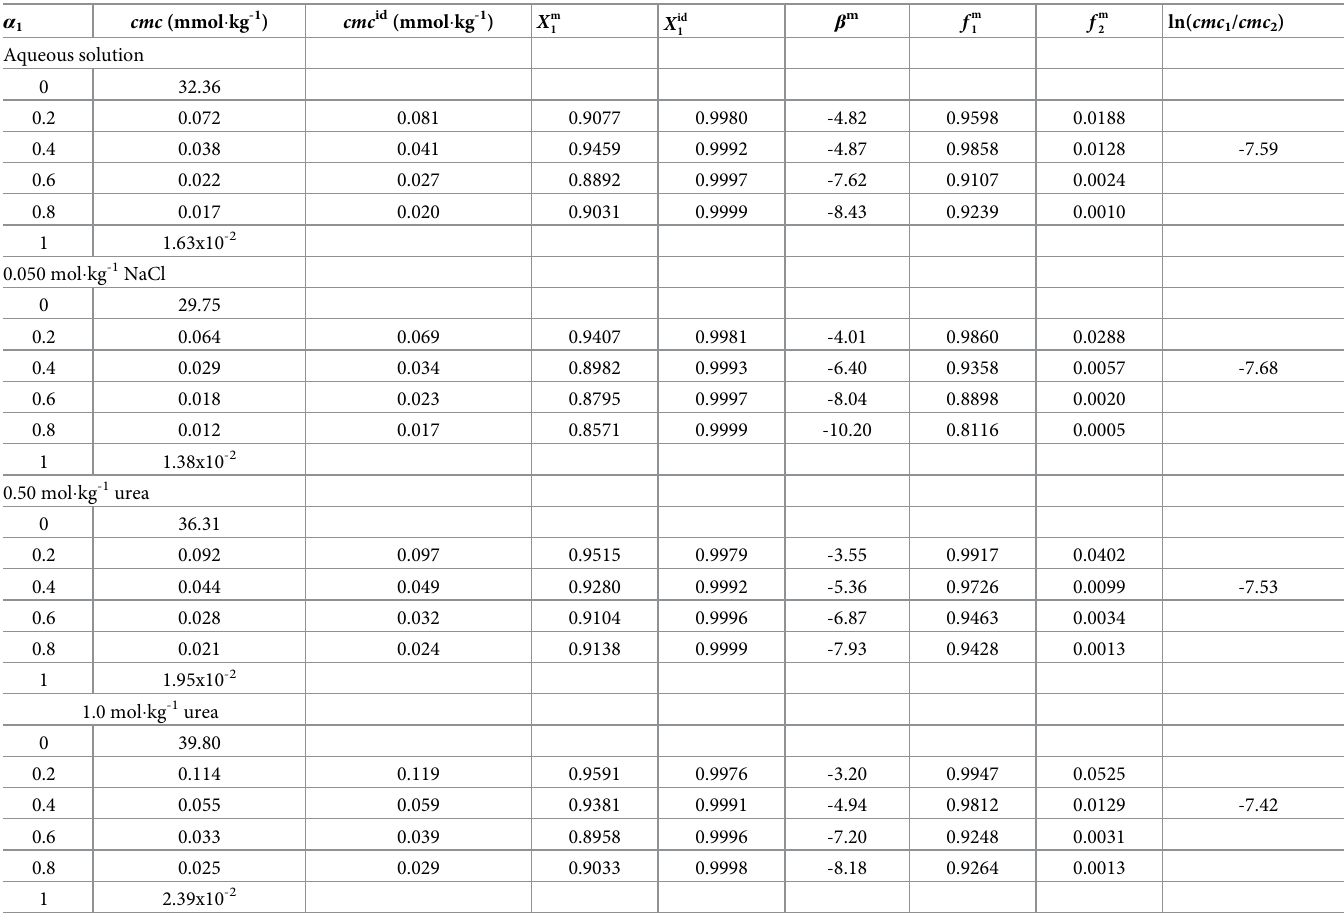
Table 1. Various physicochemical parameters for AMT+14-E2-14 mixed system in different solvent at 298.15